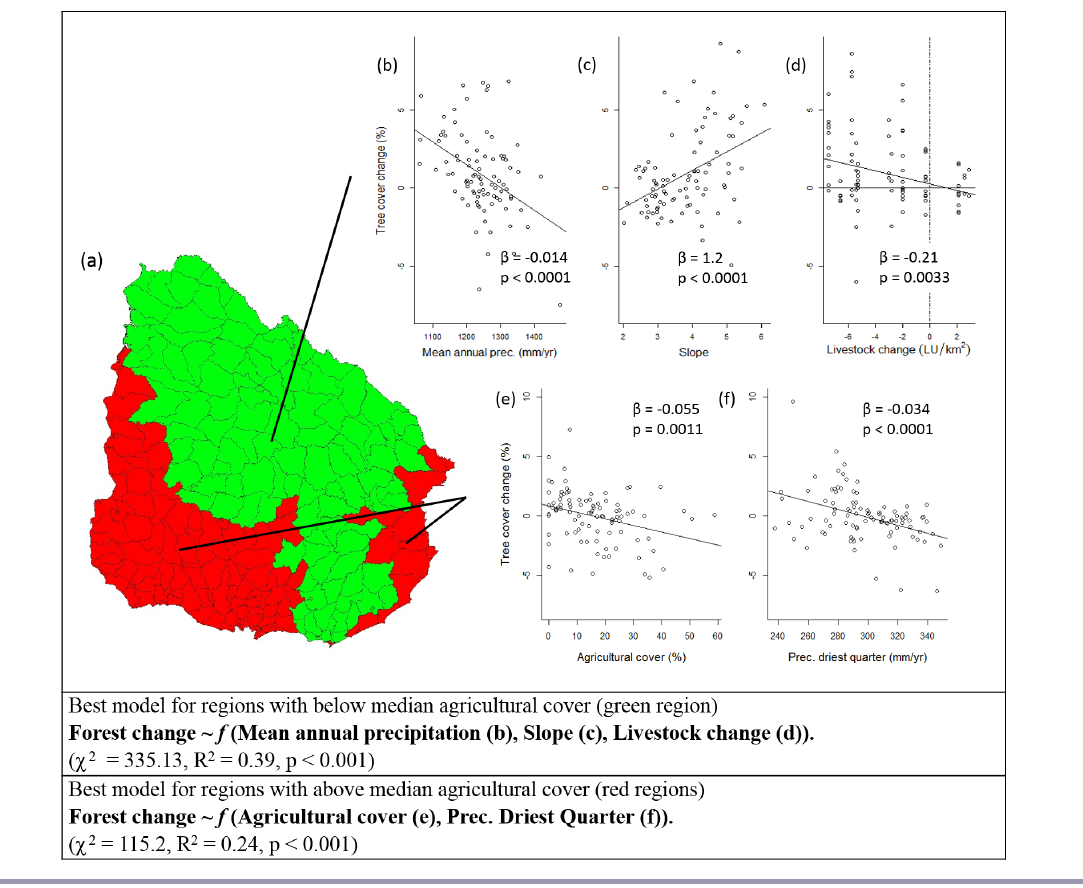
Fig. 3 . Forest cover change and drivers in regions below (green) and above (red) median agricultural cover. (a) Census divisions of Uruguay were grouped into seven edapho-topographic regions that where classified into two categories. Bottom panels: Generalized linear models of forest cover change (%) between 1966 and 2011 for regions below and above the median agricultural cover. (b-f) Partial plots presented to highlight the individual effects of predictors (Sibly et al. 2012). LU, livestock units; prec.,